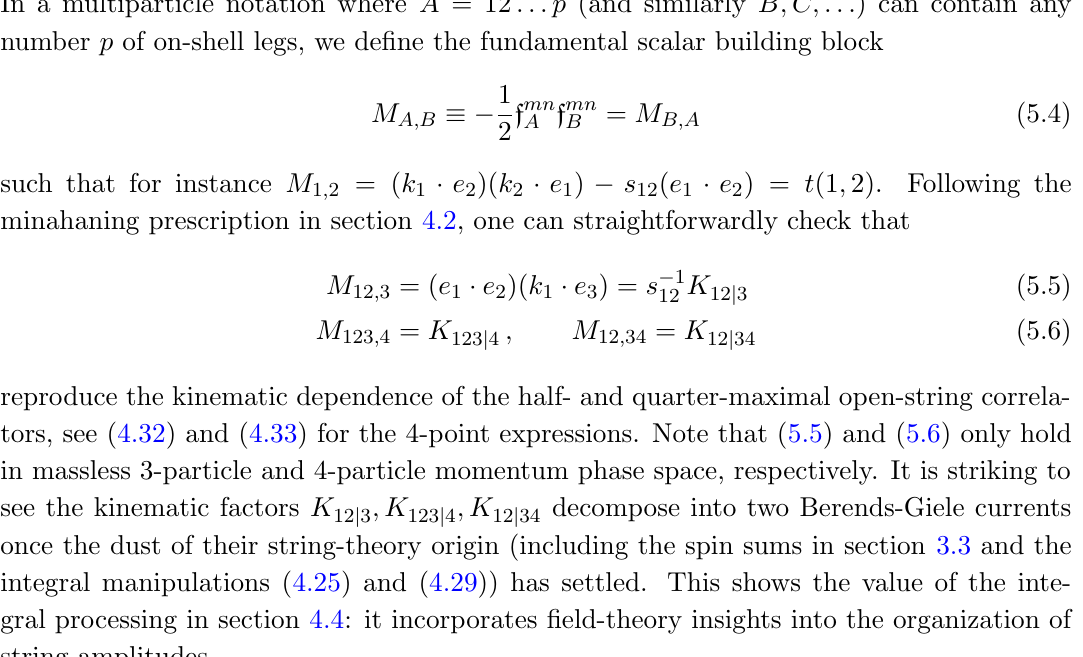
leg whose kinematic contributions are (cid:1) (cid:1) (cid:1) ; f mn and e m ; f mn , 12 12 123 123